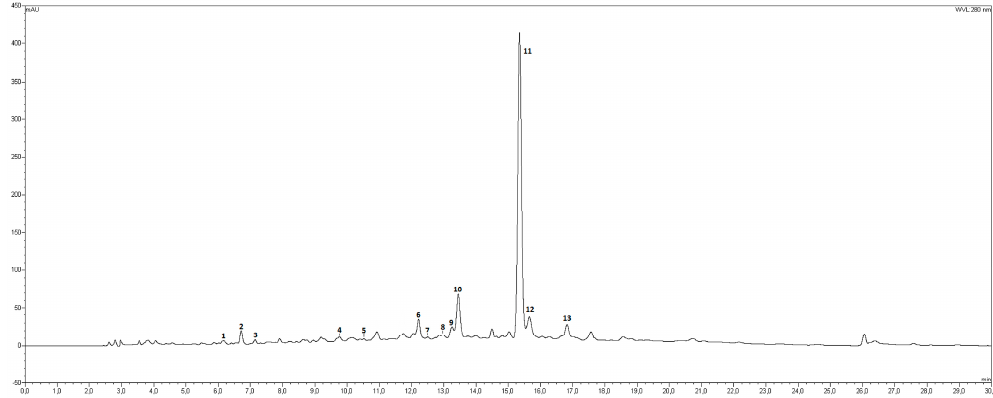
Figure 1. HPLC-DAD profile, visualized at 280 nm, of the olive leaf extract (OLE) object of this study. Phenolic compounds tentatively identified (see text and Table 1 for peak list and details): (1) hydroxytyrosolglucoside; (2) hydroxytyrosol; (3) DOPAC; (4) chlorogenic acid; (5) caffeic acid; (6) verbascoside; (7) p-coumaric acid; (8) ferulic acid; (9) rutin; (10) luteolin 7- O -glucoside; (11) oleuropein; (12) apigenin 7- O -glucoside; (13) ligstroside.